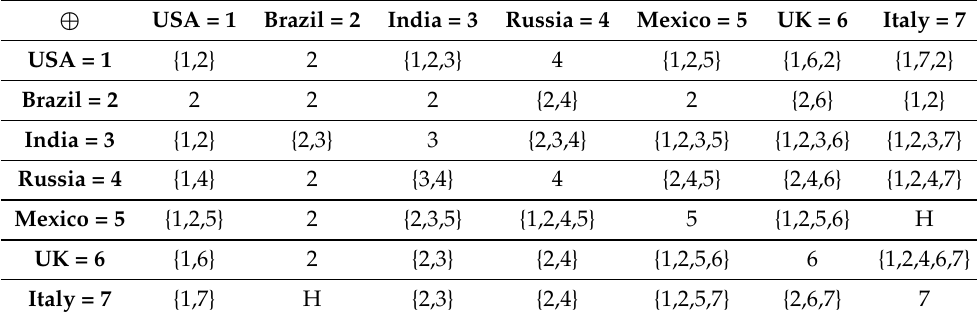
Table 4. Hypergroupoid ( H , ⊕ )